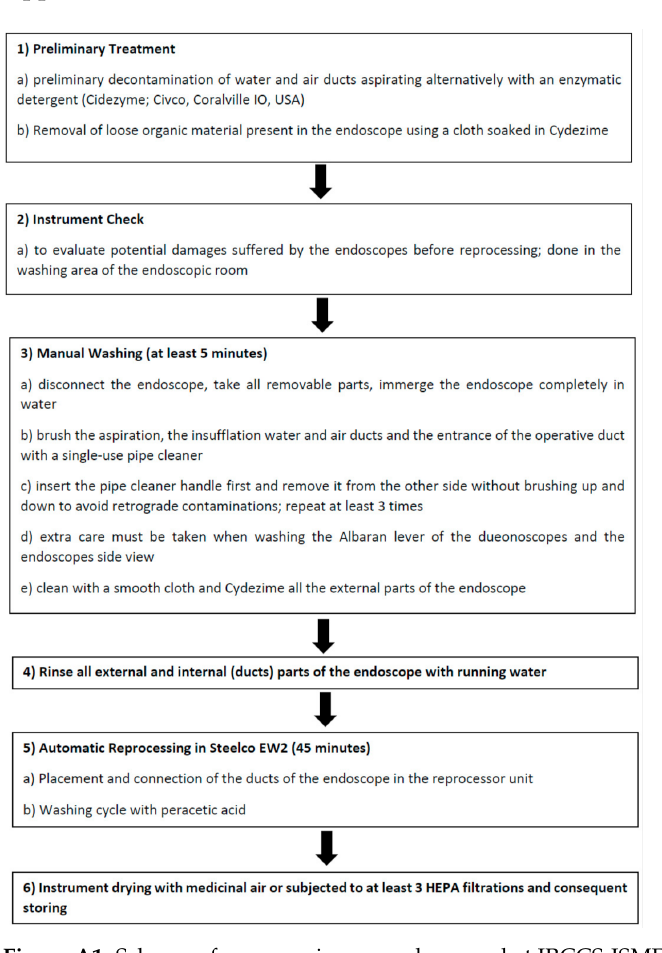
Figure A1. Scheme of reprocessing procedure used at